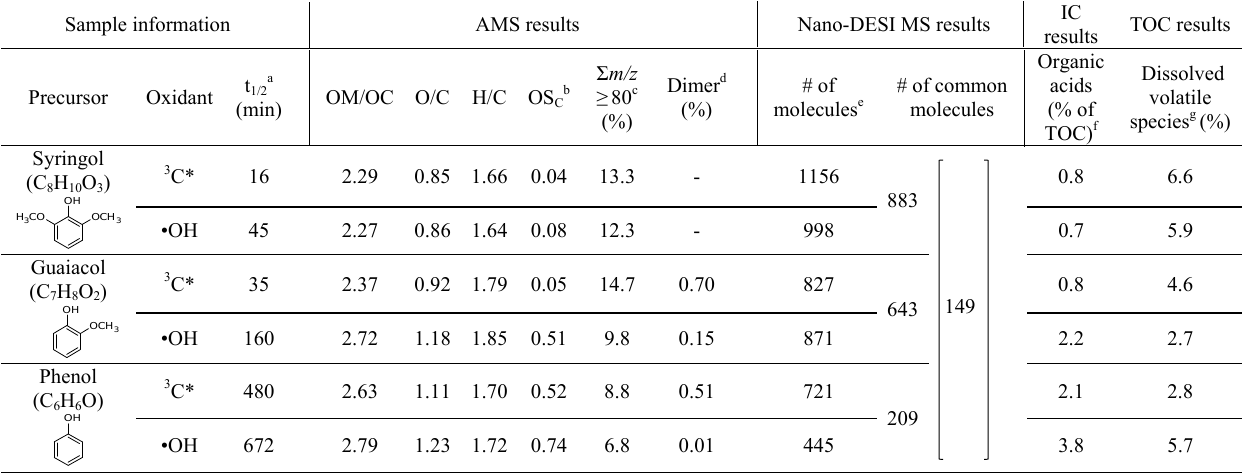
Table 1. Summary of the chemical characteristics of phenolic aqSOA formed under different experimental conditions.